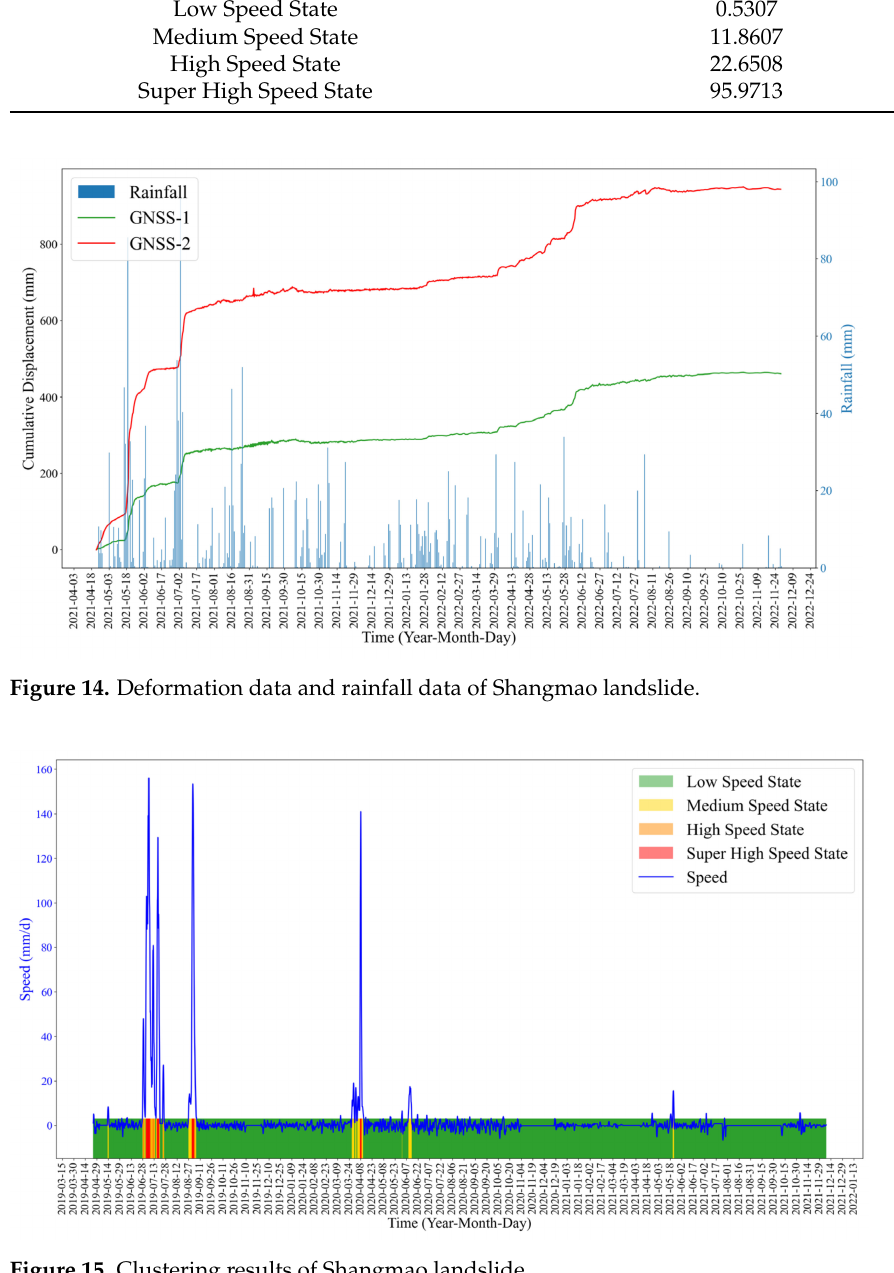
Figure 15. Clustering results of Shangmao